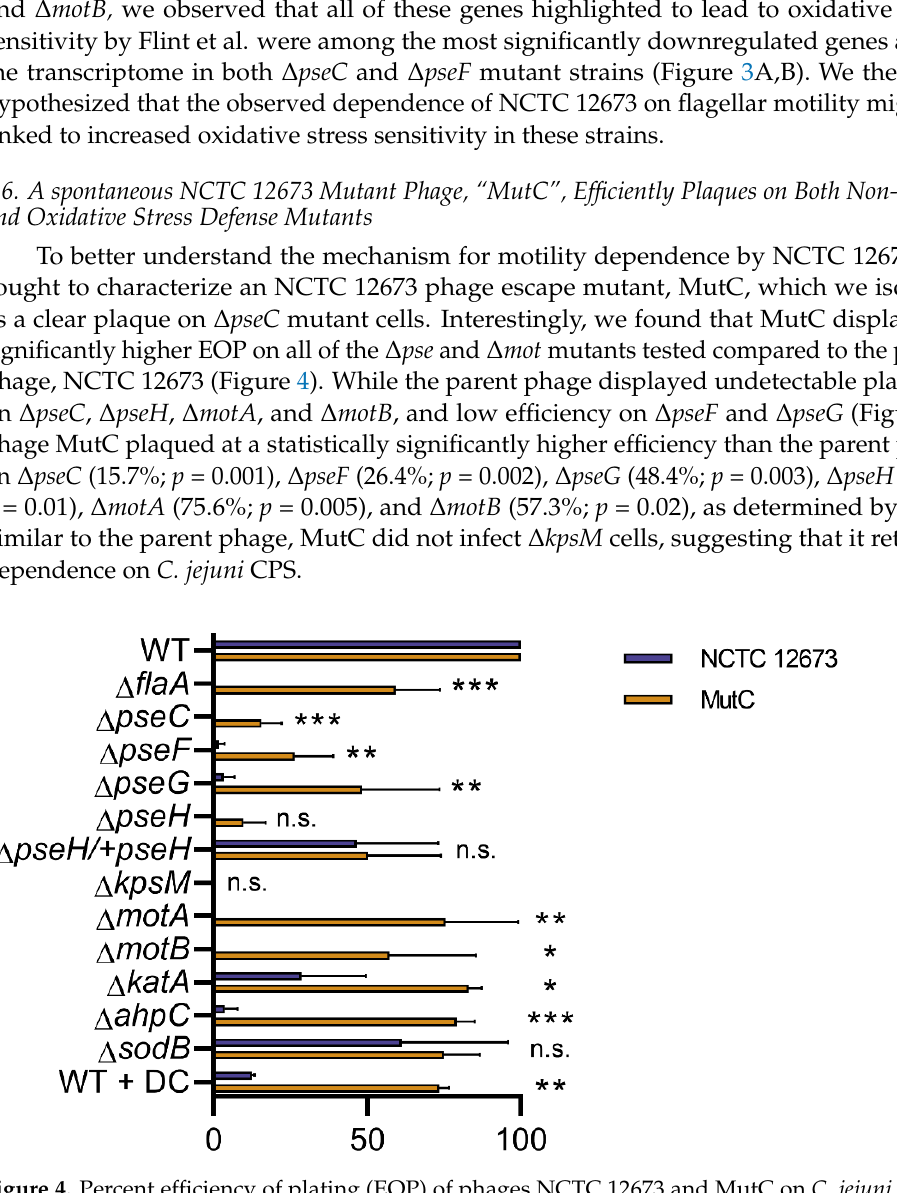
Figure 4. Percent efficiency of plating (EOP) of phages NCTC 12673 and MutC on C. jejuni NCTC 11168 wild type (WT) and isogenic mutants in pseudaminic acid biosynthesis ( pseCFGH ), flagellar motor ( motAB ), and oxidative stress defense genes ( katA, ahpC, sodB ), as well as WT cells in the presence of 0.05% deoxycholate (DC), an oxidative stress-inducing agent for Campylobacter [35]. Bars represent the mean of three to six biological replicates (with the exception of WT+DC, which represents the mean of two biological replicates). Statistical significance between NCTC 12673 and MutC phage for each strain was determined by unpaired t -test and is indicated by asterisks as follows: p < 0.05 (*), p < 0.01 (**), p < 0.001 (***). n.s: no significant difference between NCTC 12673 and MutC.